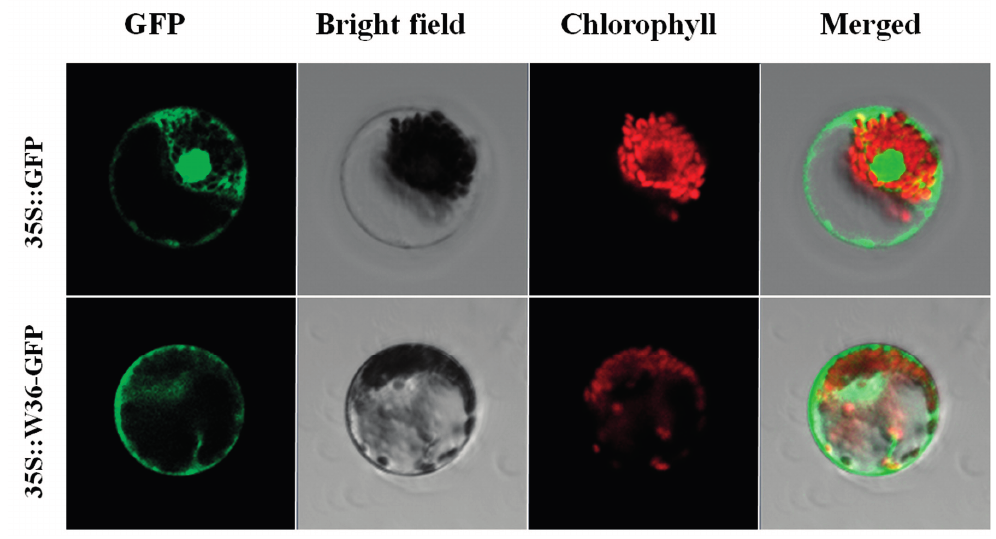
Figure 4. W36 subcellular localization. The 35S:: W36 -GFP and 35S::GFP control vectors were transiently expressed in wheat protoplast cells by PEG. Results were visualized by confocal microscopy. Bars = 10 μ